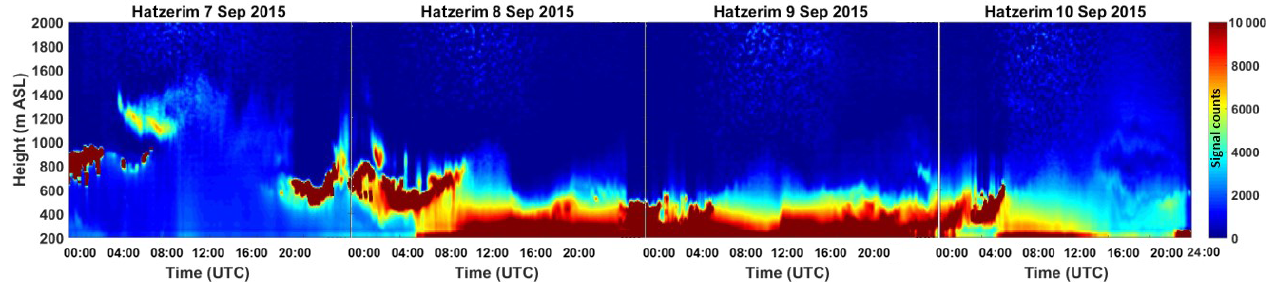
Figure 12. Hatzerim ceilometer signal counts plots for 7–10 September 2015. The y axis is the height from site deployment to 2000ma.s.l., the x axis is the time in UTC, and the signal count scale ranges between 0 and 10000.